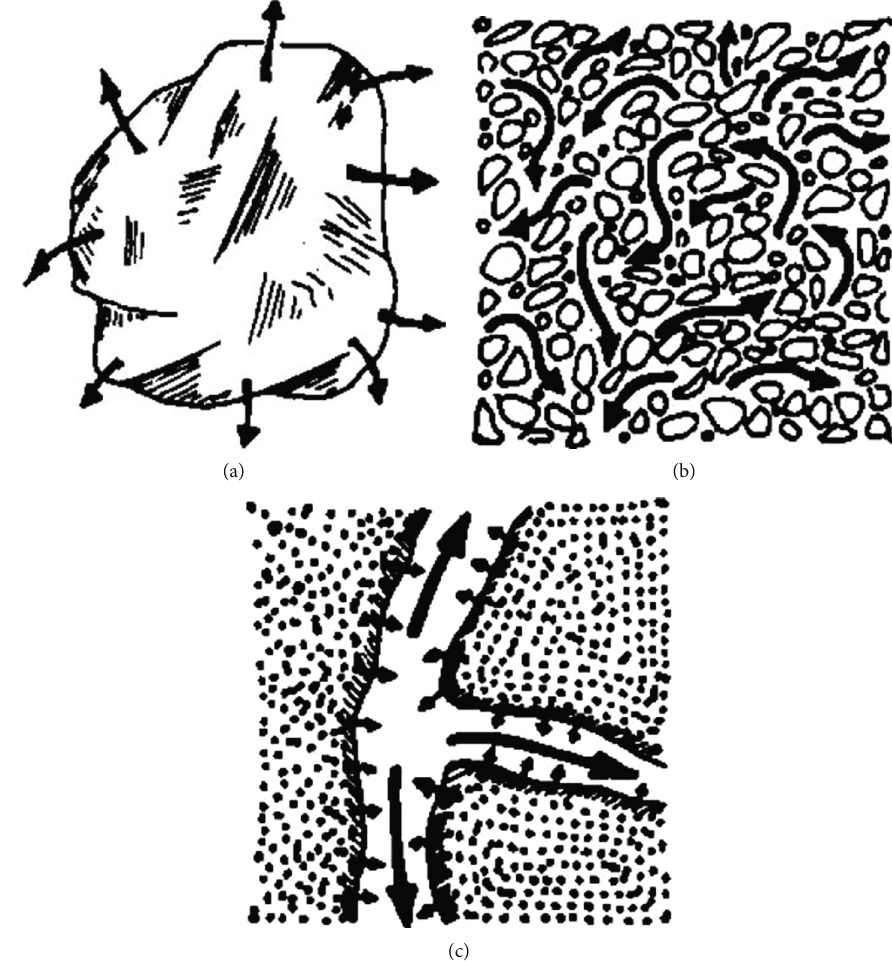
Figure 1: Schematic diagram of desorption-di ff usion fl ow of coalbed methane [3]. (a) Desorbs from the inner surface of coal, (b) di ff uses through matrix and micropores, and (c) fl ows in natural fracture networks.